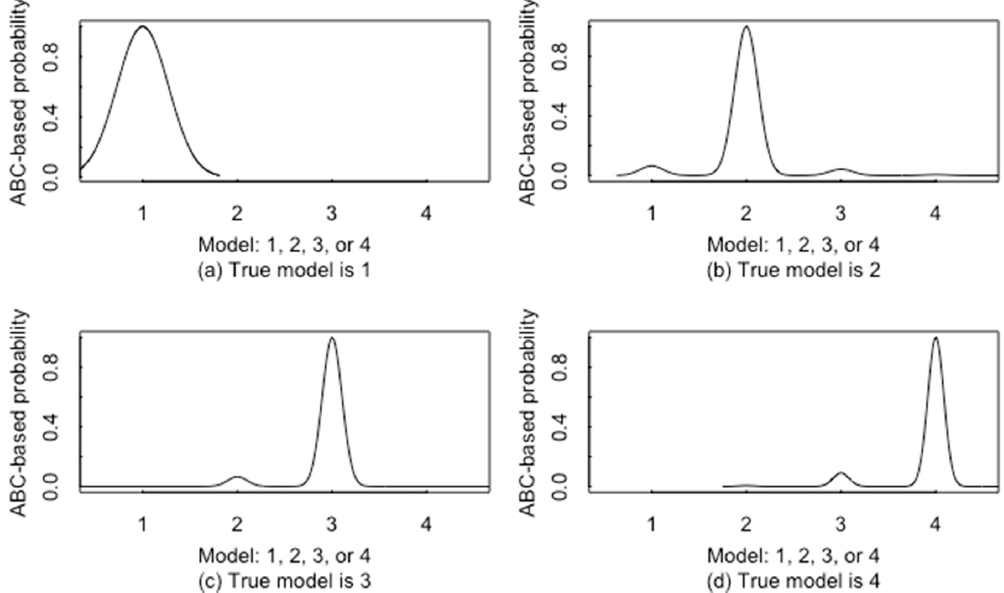
Figure 10. Principle coordinate plot obtained using multidimensional scaling applied to real and simulated spectra for Lu-177m and WgPu.